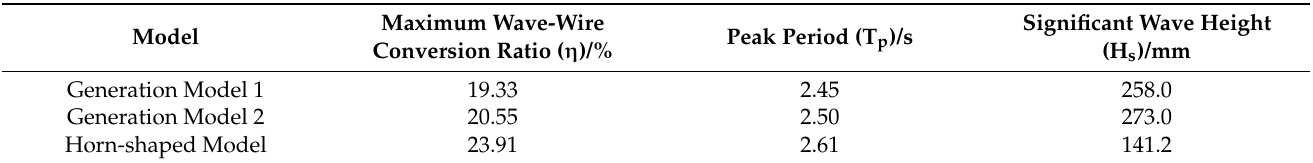
Table 7. Irregular wave test results of three test